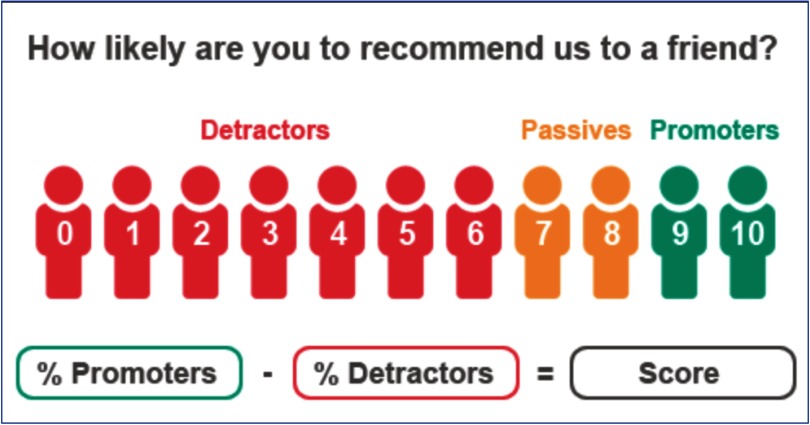
Calculating the Net Promoter ScoreSource: How Likely: https://www.howlikely.com/resources/nps-what-exactly-is-it